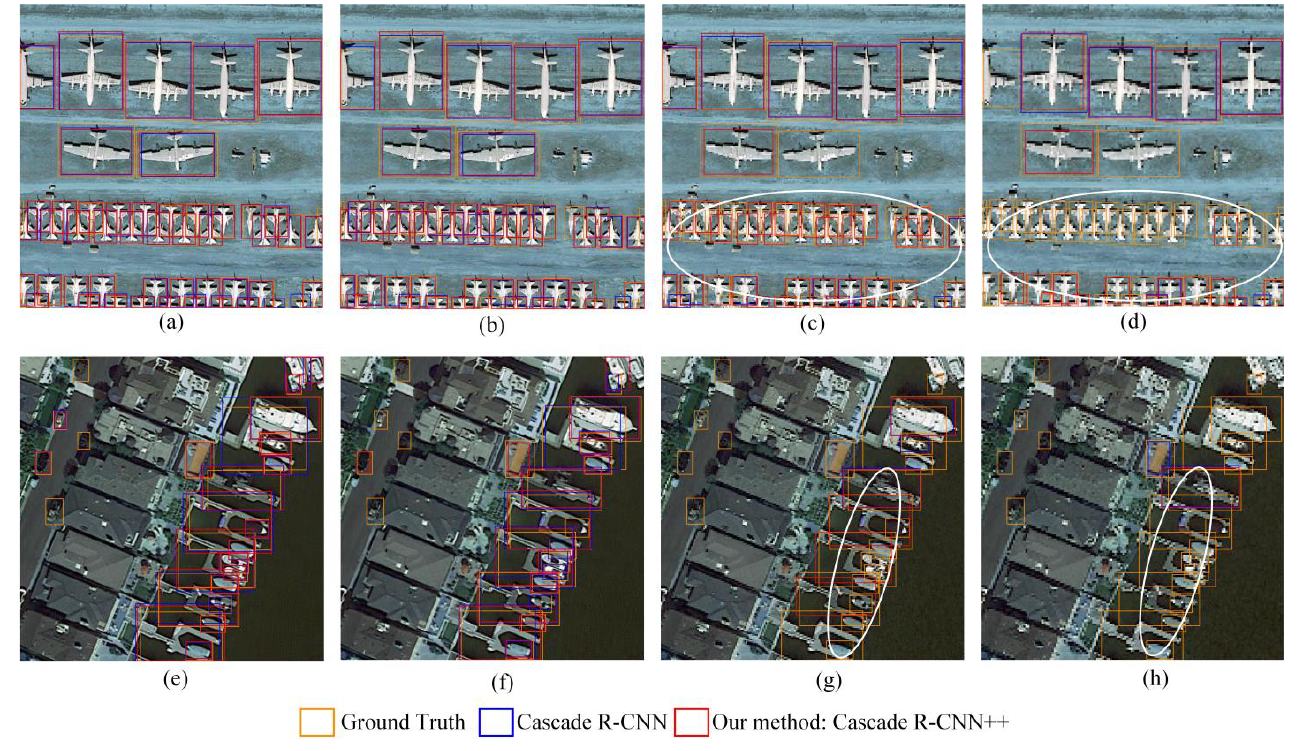
Figure 8. Examples of multi-object detection across multi-resolution remote sensing images. ( a ) Detection of airplanes on the original resolution image (no upscale); ( b ) detection of airplanes on the image upscaled by a factor of two; ( c ) detection of airplanes on the image upscaled by a factor of three; ( d ) detection of airplanes on the image upscaled by a factor of four; ( e ) detection of harbors on the original resolution image (no upscale); ( f ) detection of harbors on the image upscaled by a factor of two; ( g ) detection of harbors on the image upscaled by a factor of three; ( h ) detection of harbors on the image upscaled by a factor of four.